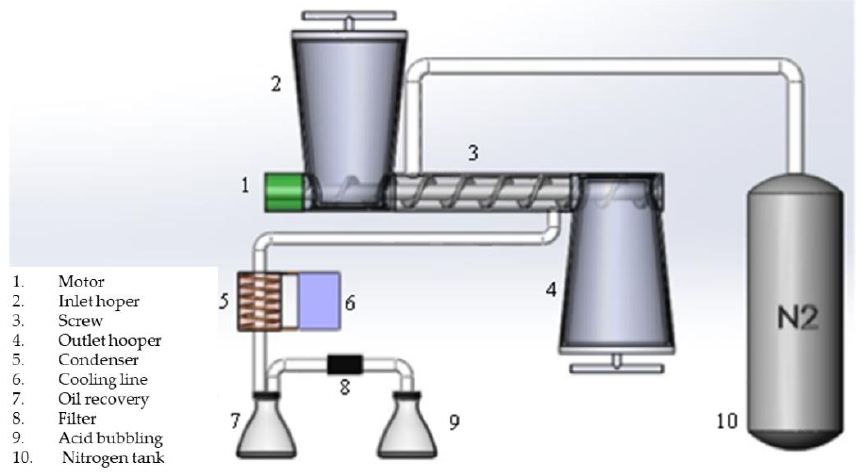
Figure 1. In - house pilot - scale furnace used for the pyrolysis of CCA - treated wood . Figure 1. In-house pilot-scale furnace used for the pyrolysis of CCA-treated